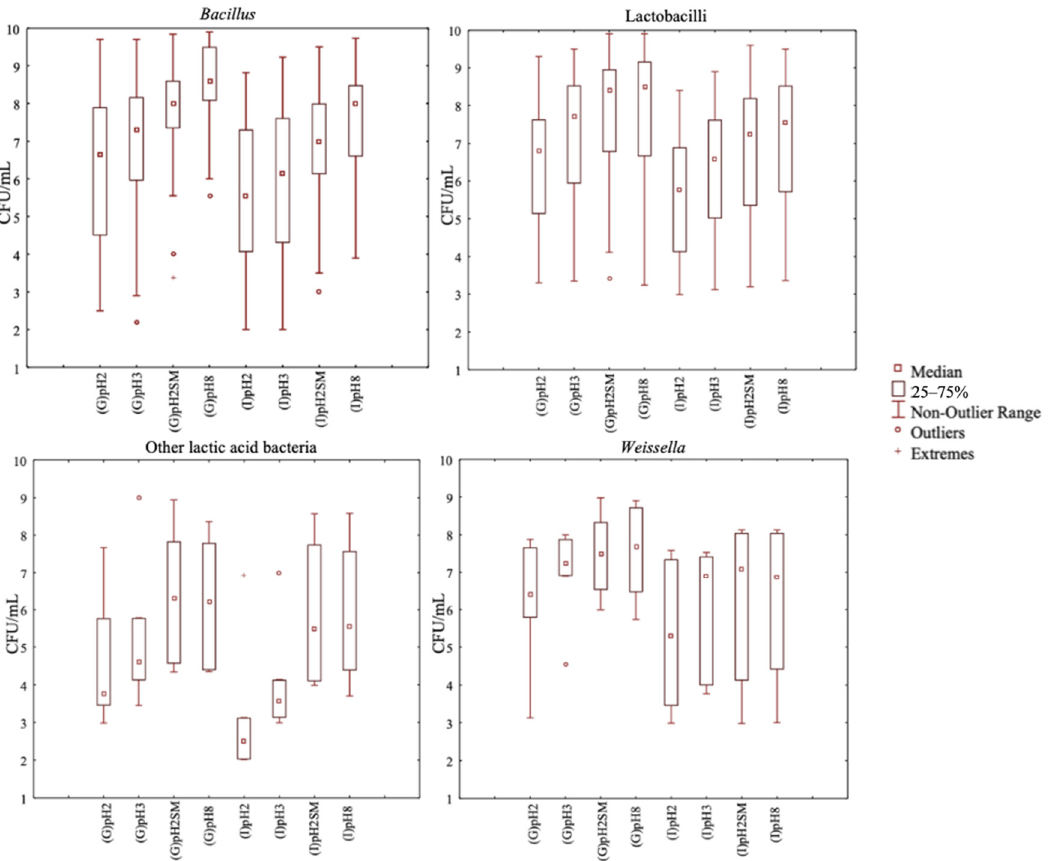
Figure 1. Viable cell count (CFU/mL) of the bacterial strains tested for their resistance to the gastro (G) and then intestinal (I) transit in vitro at different conditions: pH 2 (pH2), pH 3 (pH3), pH 2 plus skim milk (pH2SM), and pH 8 (pH8). All strains belong to Bacillus , lactobacilli, Weissella , Leuconostoc , and Pediococcus species. The group named “other lactic acid bacteria” includes Leuconostoc and Pediococcus strains.